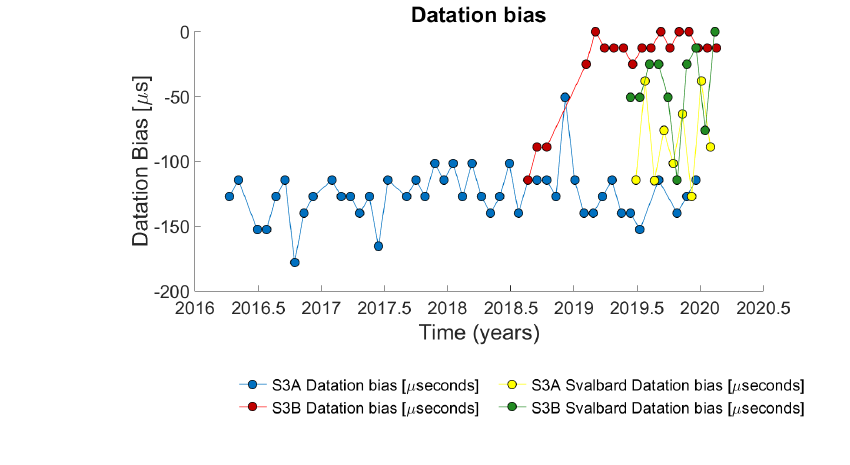
Figure 23. Datation bias